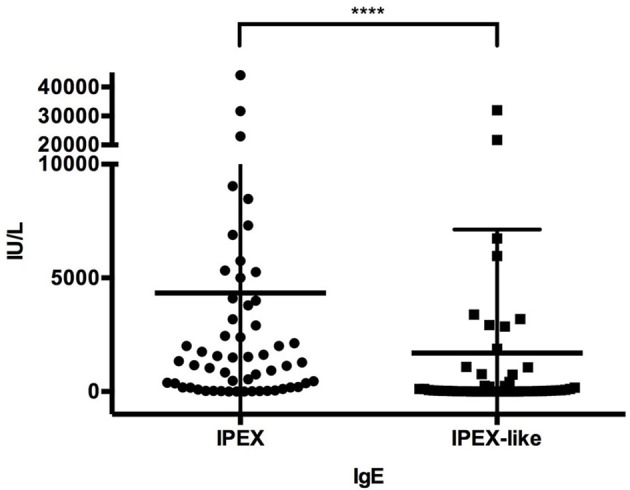
IgE levels in IPEX and IPEX-like patients. Mean and SD are shown (****p < 0.0001).